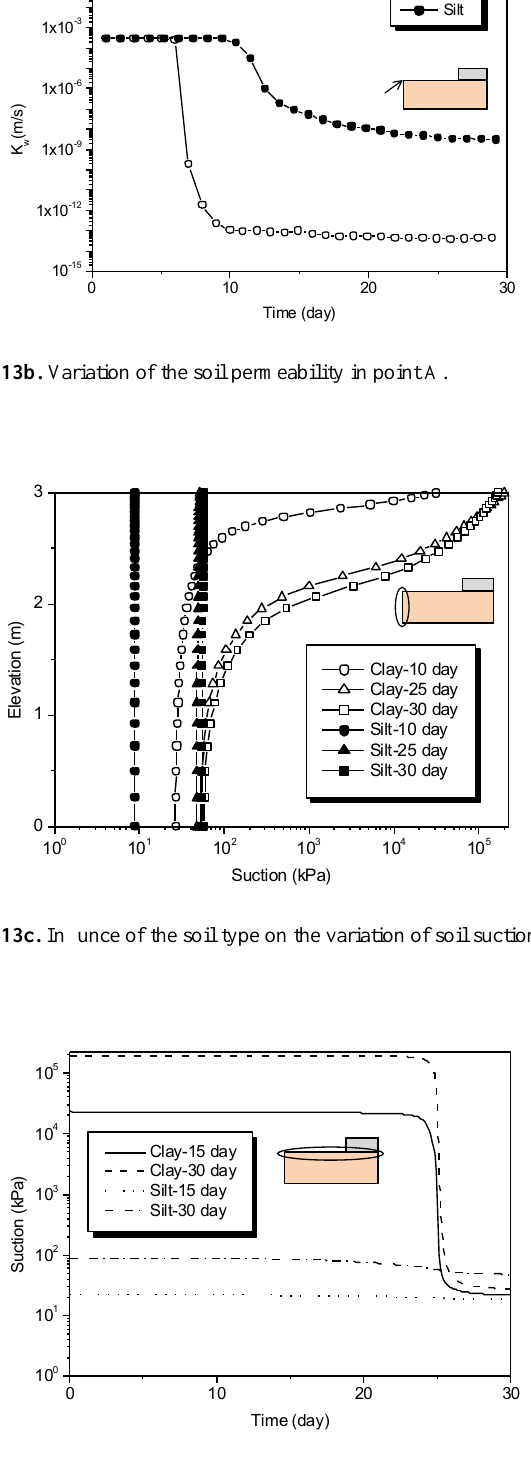
Figure 13a. Influnce the soil type on the variation of the suction in point A